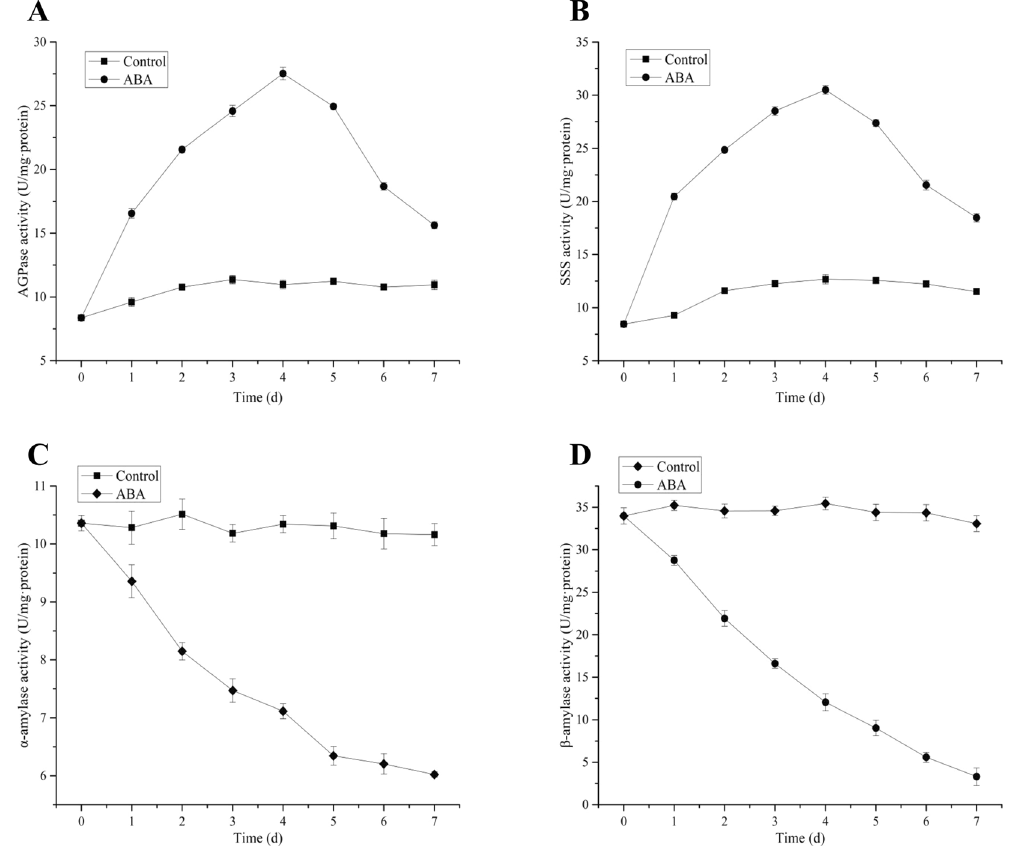
Figure 6. AGPase, SSS, α -amylase, and β -amylase activity. ( A ) AGPase activity; ( B ) SSS activity ( C ) α -amylase activity; ( D ) β -amylase activity. All data are presented as the mean of triplicate measurements ± standard